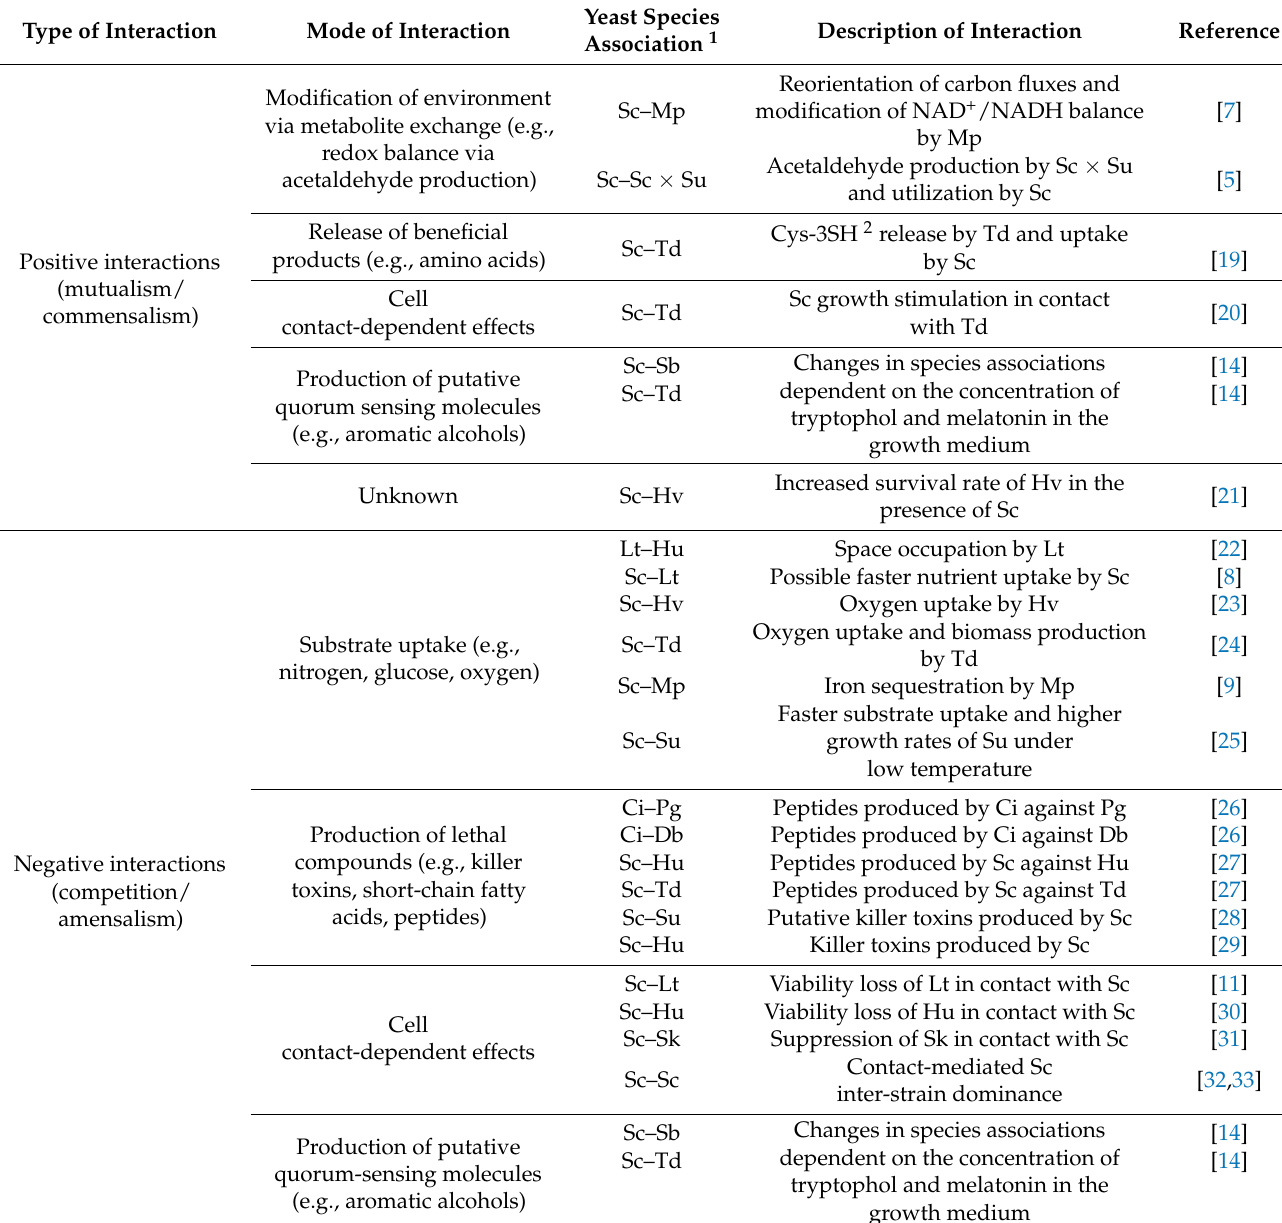
Table 1. Type and mode of inter- and intra-species yeast interactions in